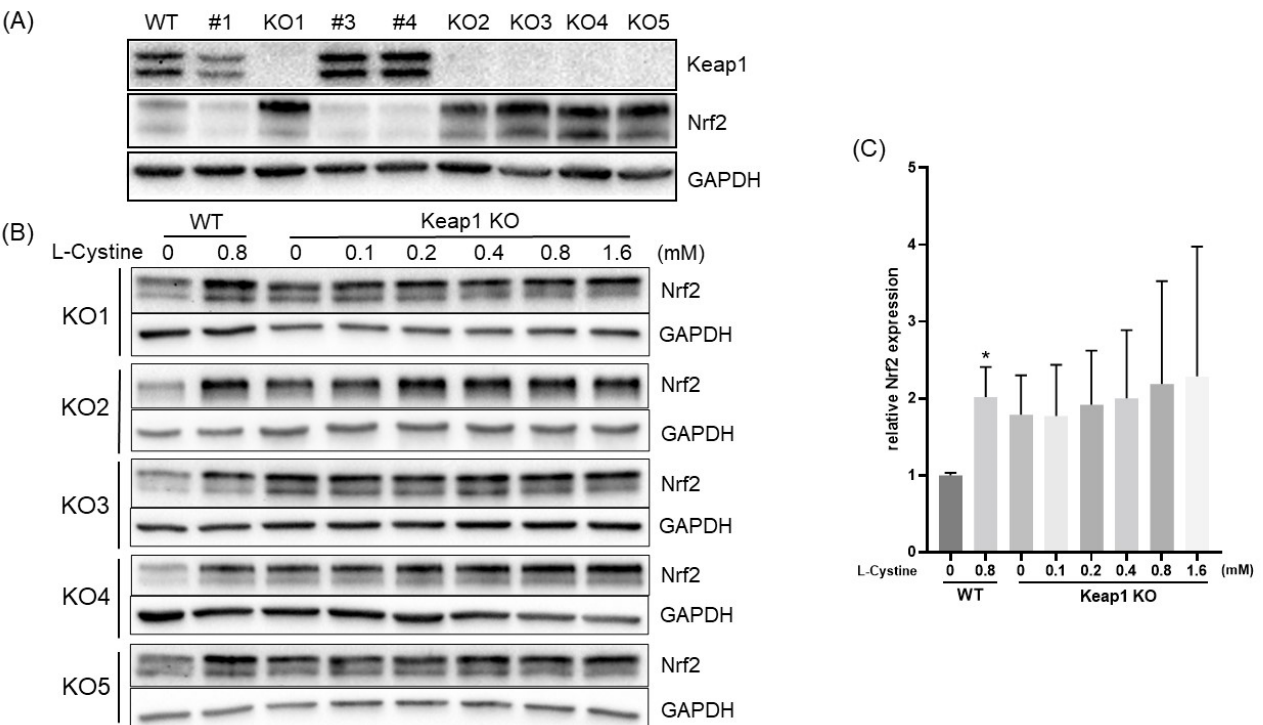
Figure 11. Keap1 Dependent Nrf2 Protein Induction by L-Cystine. HeLa cells were transfected with Keap1 CRISPR/Cas9 KO Plasmid for clonal selection. The clones with Keap1 knockout display a loss of Keap1 protein and elevated Nrf2 protein ( A ). The parent wild-type or Keap1 KO clones were treated with indicated doses of L-Cystine for 4 h before harvesting to measure the induction of Nrf2 protein by Western Blot, using GAPDH as a loading control ( B ). The intensities of the bands from wild-type or five clones of Keap1 KO cells were quantified using NIH ImageJ ( C ). * indicates statis- tically significant compared to 0 mM L-Cystine in WT cells by one-way ANOVA, corrected by Dun- nett’s multiple comparisons test ( C ).